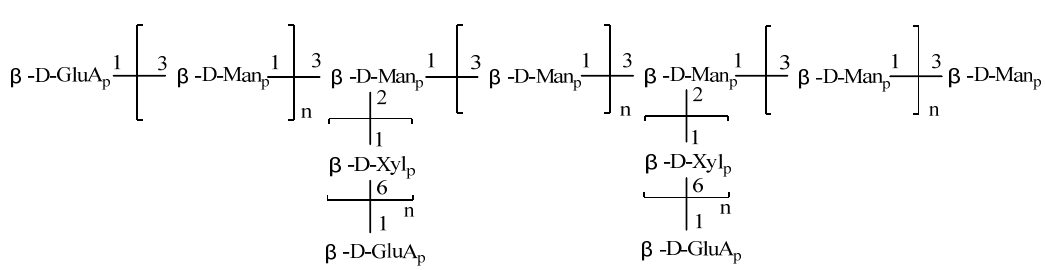
Figure 2. The structure of TP-1 to TP-6 (n ≥ 1).